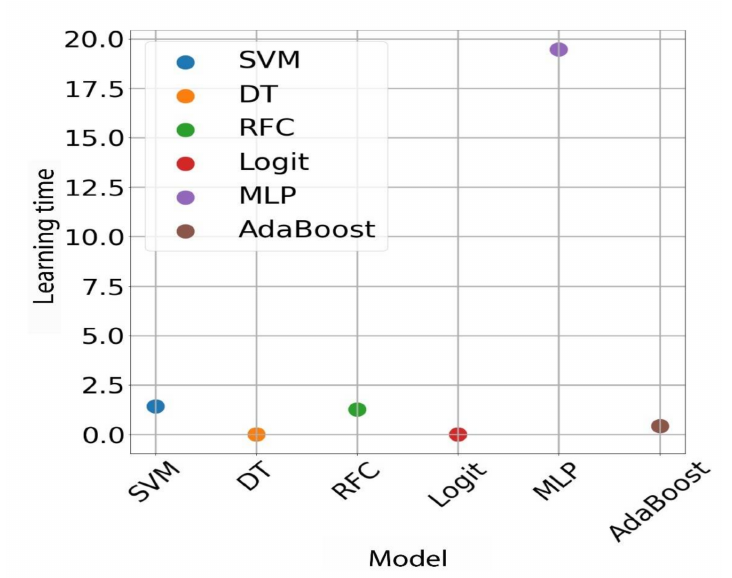
Figure 10. Average times of returning the results for individual models. Calculation times for unbalanced